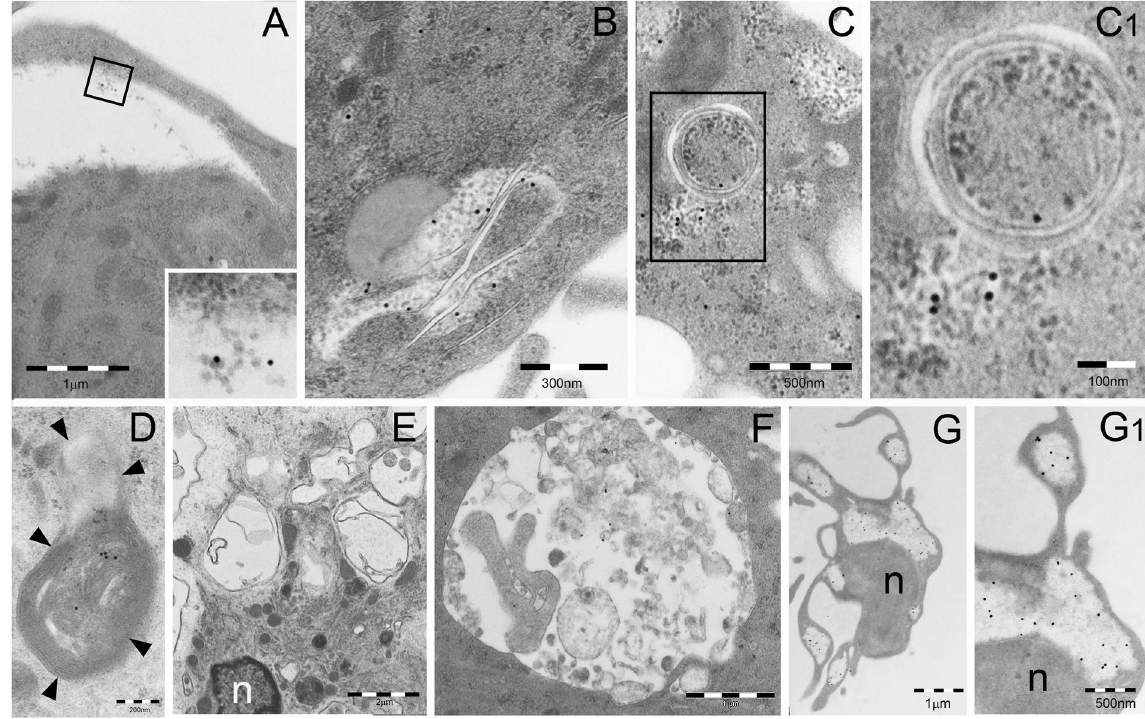
Figure 5. TEM analysis of PaCS autophagy and bleb formation in IL4-DC after IL-4 withdrawal. TEM of cells incubated for 5 days with GM-CSF plus IL-4 and then for 3 ( A–D ) or 5 ( E–G ) days in RPMI–FBS without cytokines. ( A ) A clear area, not delimited by membrane, was seen in the cytoplasm of a DC. This was identified as an empty PaCS, due to its residual barrel-like particles and 20S immunogold reactivity, visible at higher magnification in the inset. ( B–D ) Autophagic double or multilayered membranes penetrate and wrap/envelope cytoplasmic areas containing FK1-positive PaCS. See structural details in the enlargement (C1) and p62 immunoreactivity of an autophagosomal vesicle with fused multilayered membranes in ( D ). ( E – G ) A collection of empty autophagic vesicles and no PaCS are seen in ( E ), while in ( F ) a single-membrane vesicle shows heterogeneous, lysosome-type dense bodies and sparse, residual immunogold reactivity for the autophagic marker LC3. ( G ) FK1-reactive PaCS were still recognized in the cytoplasm as well as in the cell blebs, although most barrel-like particles were dissolved. Nuclear and cytoplasmic densification, with loss of details and organelles, were indicative of ongoing apoptosis. See enlargement in (G1). n,